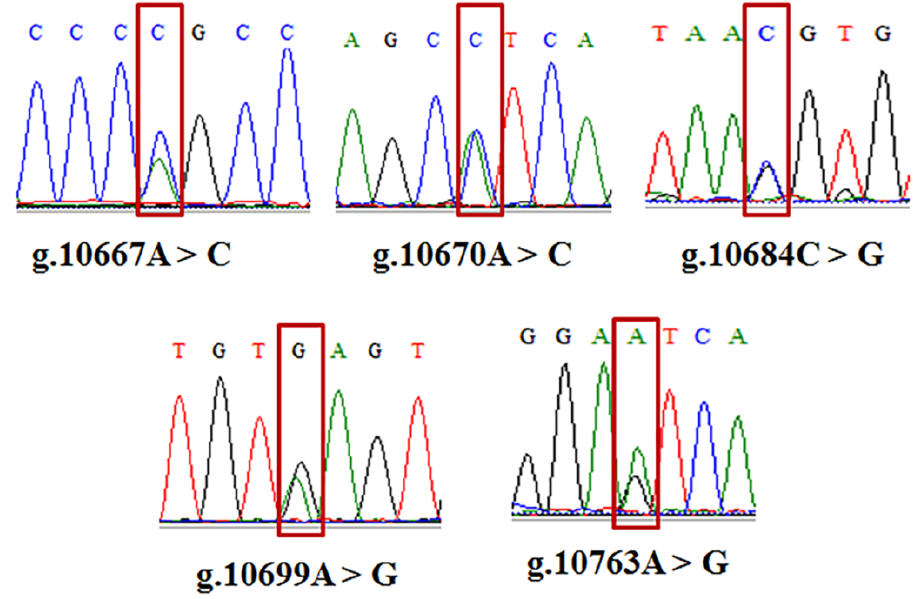
Figure 5. The five mutation sites with F2R2 primers in GHRHR gene. The SNPs in exon10 were missense mutations (g.10667A > C: Glutamine (Gln) → Pro- line (Pro); g.10670A > C: Histidine (His) → Pro). Figure 6 shows the predicted 3D structure GHRHR (g.10667A > C and g.10670A > C). The figures indicated there was no change in